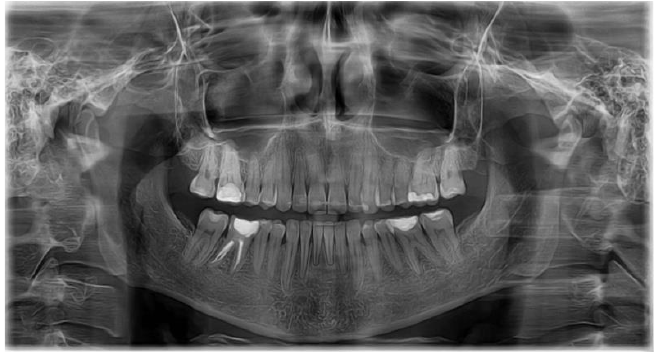
Figure 4. Final panoramic radiograph.